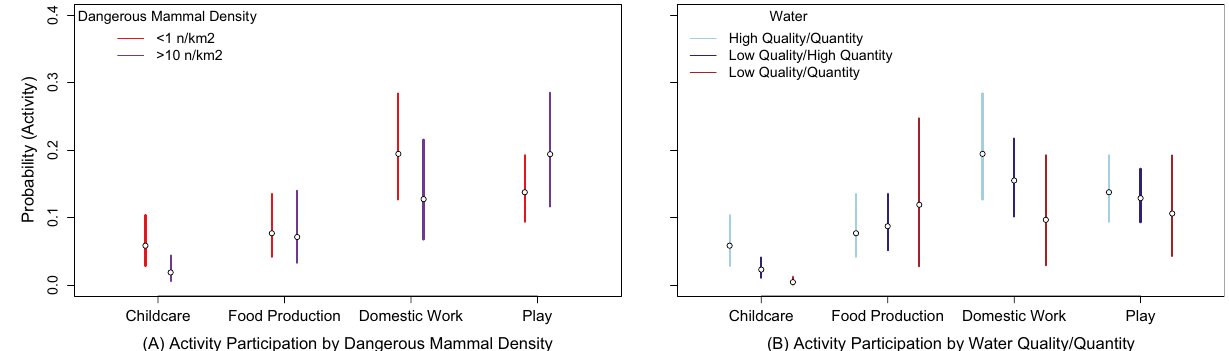
Figure 3. Model 4 predictions for the probability that a child engages in Childcare, Food Production, Domestic Work, and Play as a function of ( A ) Dangerous Mammal Density and ( B ) Water Quality/Quantity for children in middle childhood. Proportion Non-Foraged Food is held at the sample mean. Gender is held at the reference value (girls). Water Quality/Quantity and Dangerous Mammal Density are held at the reference value (low risk) in ( A ) and ( B ) respectively. Intervals represent 89th percentile credible intervals, as calculated from the posterior samples.